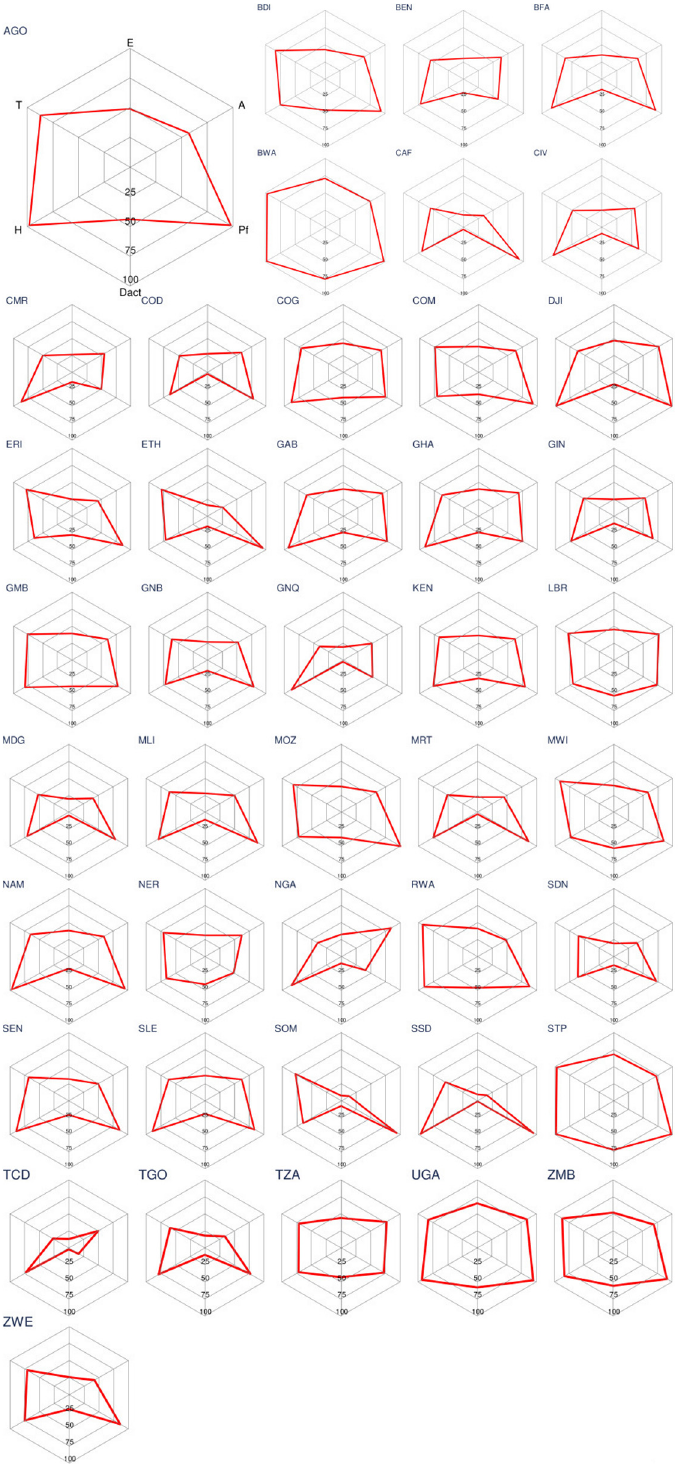
Fig 2. Effective Coverage and Malaria Service Performance Indicators by Country (%). Labeled on the axis are: E Effective coverage; A Access to any care provider; Pf Access to a formal care provider; Dact Compliance with the first-line antimalarial treatment; H Adherence; T Cure rate. Labels for country ISO3 codes are listed in the S1 Table.